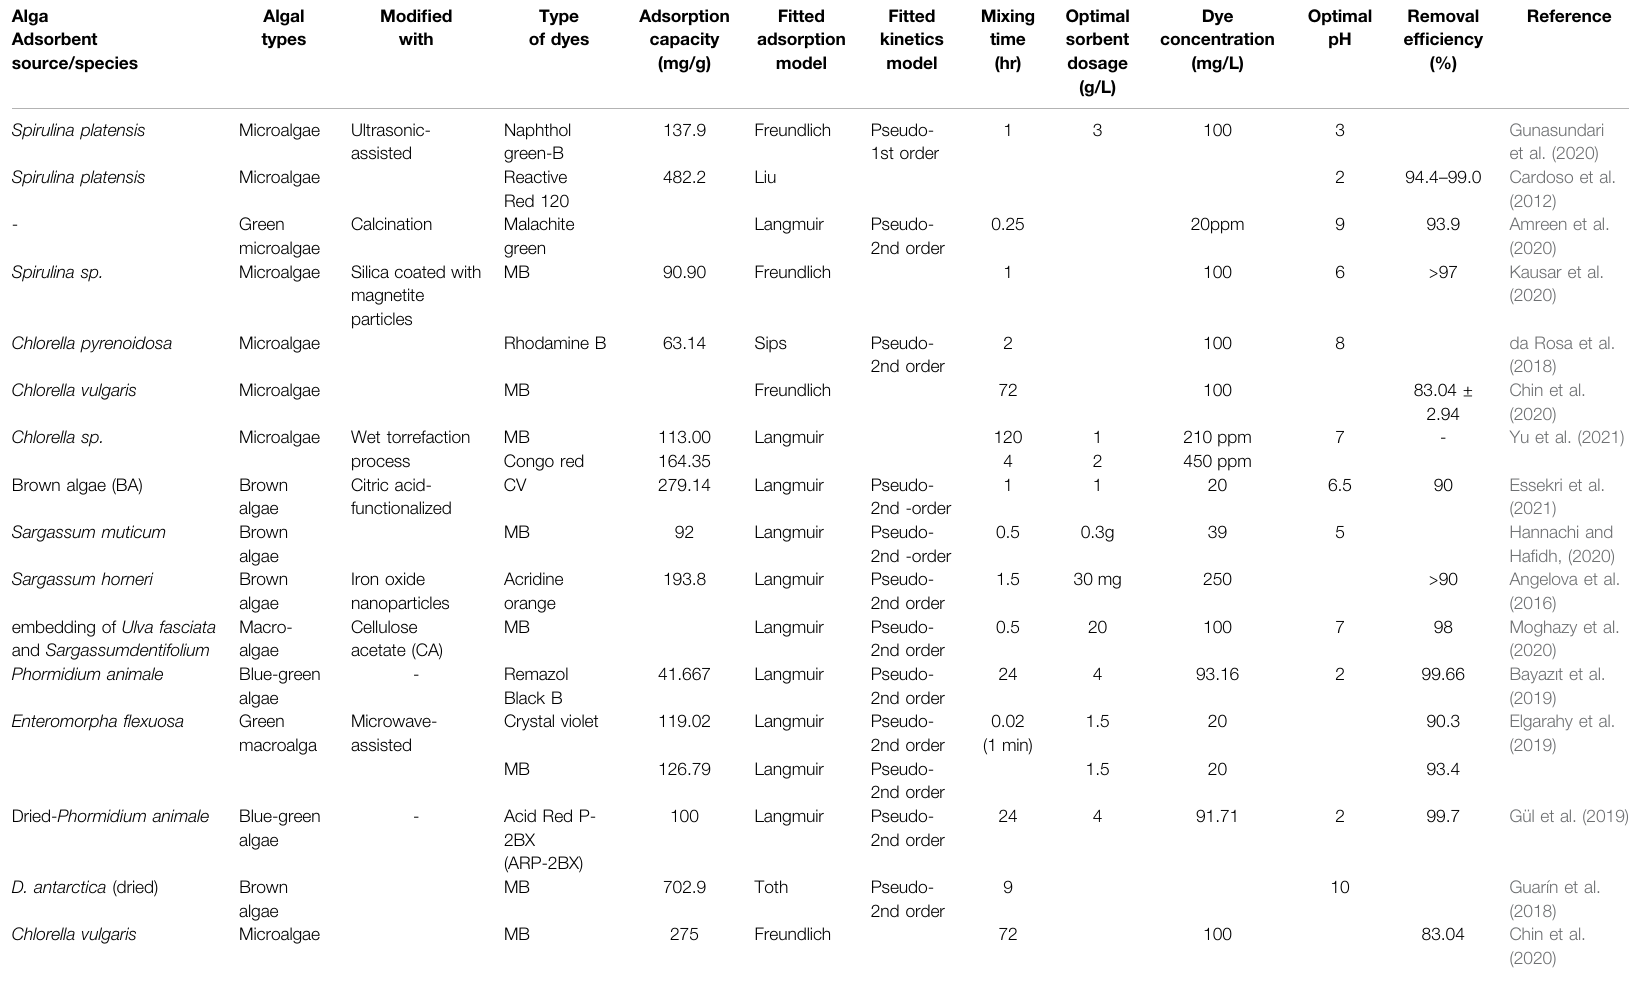
TABLE 4 | Application of some of the species from algal biomass for dye